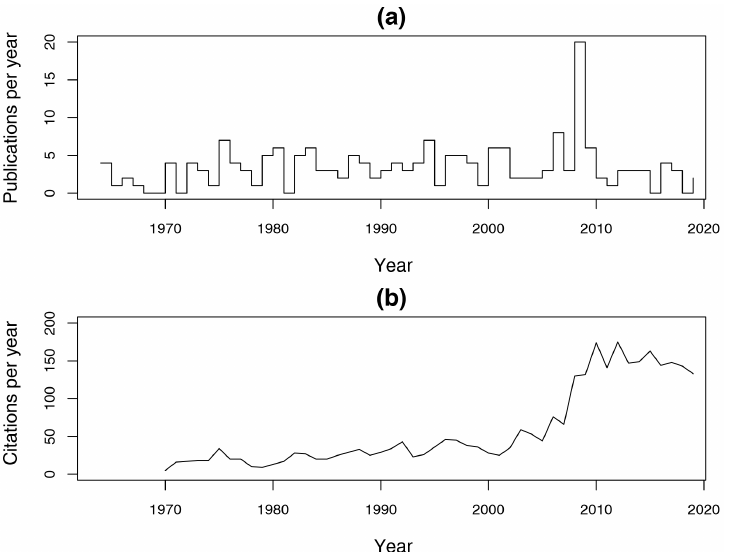
Figure 5. (a) Number of papers published annually, as author or co-author. (b) Annual number of citations of Rycroft’s papers. Plots created in 2020 with data from Web of Science from 1970 to 2020; publications from 1964 to 1970 created manually from a list supplied by Michael Rycroft; citation data before 1970 are